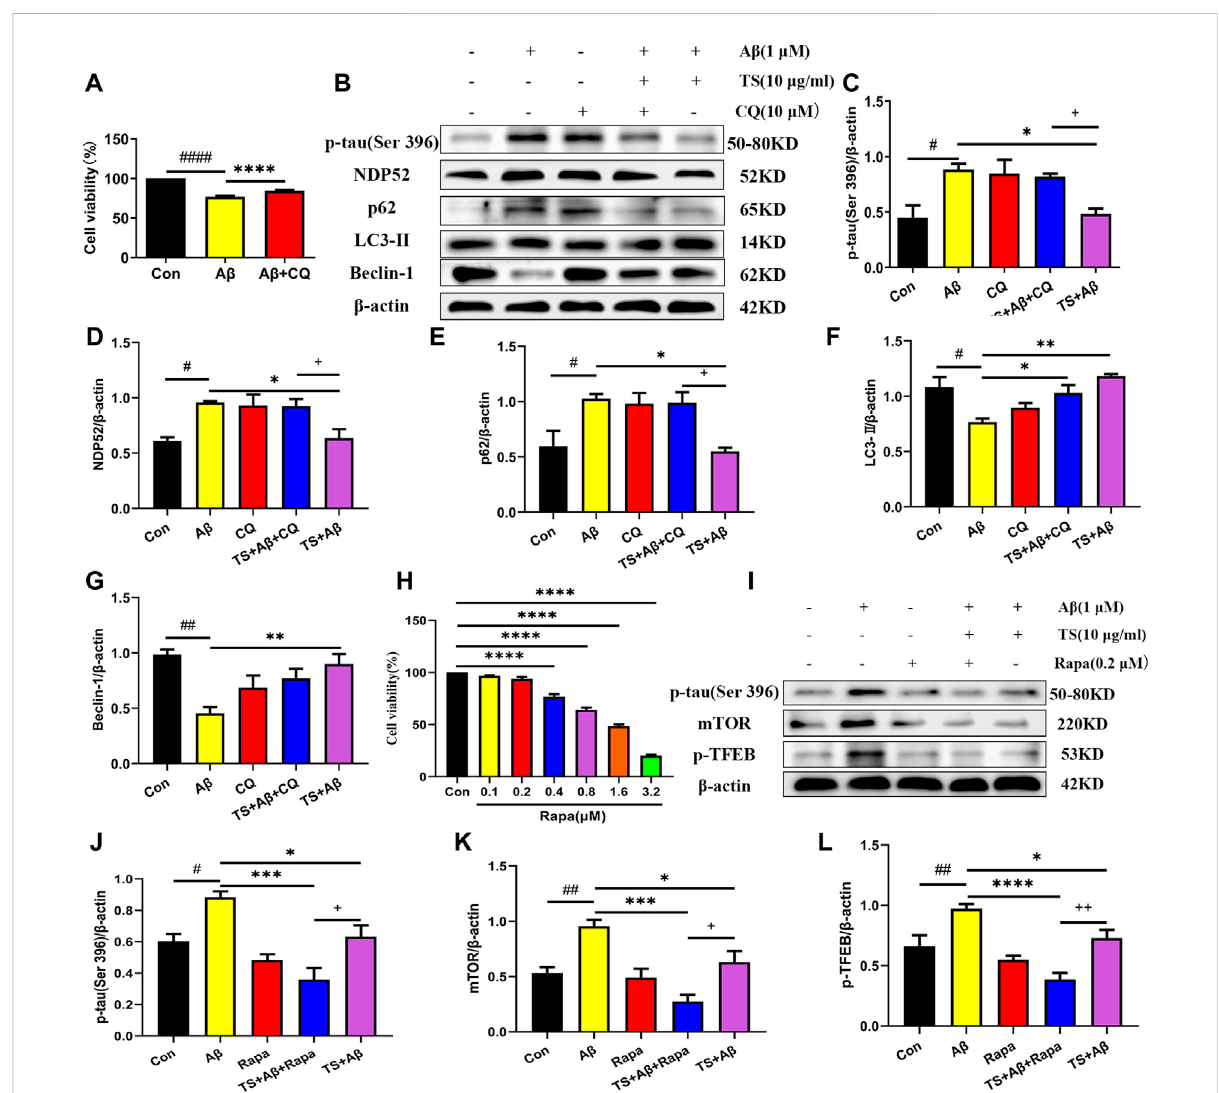
FIGURE 7 TSpromotedautophagyinA β -inducedPC12cellstoclear p- tau. (A) The effectofCQonthesurvival rateofA β -induced PC12cellsfor 24 hwas evaluated by MTT assay ( #### p < 0.0001, **** p < 0.0001). (B) The effects of CQ on expression of p- tau (Ser 396), NDP52, p62, LC3-II and Beclin-1 proteinsintheA β -inducedPC12cellsafterTStreatmentweredetectedbyWesternblot. (C) Quantitativeanalysisoftherelativeexpressionlevelof p- tau (Ser 396) protein in each group ( # p = 0.0128, * p = 0.0205, + p = 0.0495). (D) Quantitative analysis of the relative expression level of NDP52 protein ineach group( # p = 0.0134, * p = 0.0217, + p =0.0386). (E) Quantitative analysis of therelativeexpressionlevel of p62protein bandsin each group ( # p = 0.0226, * p = 0.0124, + p = 0.0200). (F) Quantitative analysis of the relative expression level of LC3-II protein in each group ( # p = 0.0101, * p = 0.0277, ** p = 0.0016). (G) Quantitative analysis of the relative expression level of Beclin-1 protein in each group ( ## p = 0.0013, ** p = 0.0056). (H) MTT assay was used to test the effect of Rapa on PC12 cells for 24 h (**** p < 0.0001). (I) The effects of Rapa on expression of p- tau (Ser 396), mTOR and p -TFEB proteins in the A β -induced PC12 cells after TS treatment were detected by Western blot. (J) Quantitative analysis of the relative expression level of p- tau (Ser 396) protein in each group ( # p = 0.00175, *** p = 0.0002, * p = 0.0315, + p = 0.0442). (K) Quantitative analysis of the relative expression level of mTOR protein in each group ( ## p = 0.0062, *** p = 0.0002, * p = 0.0305, + p = 0.0250). (L) Quantitative analysis of the relative expression level of p- TFEB protein in each group ( ## p = 0.0041, **** p < 0.0001, * p = 0.0288, ++ p = 0.0081). # : Compared with WT group; *Compared with model group; + Comparing with TS+A β group. Data are presented as mean ± SEM ( n =